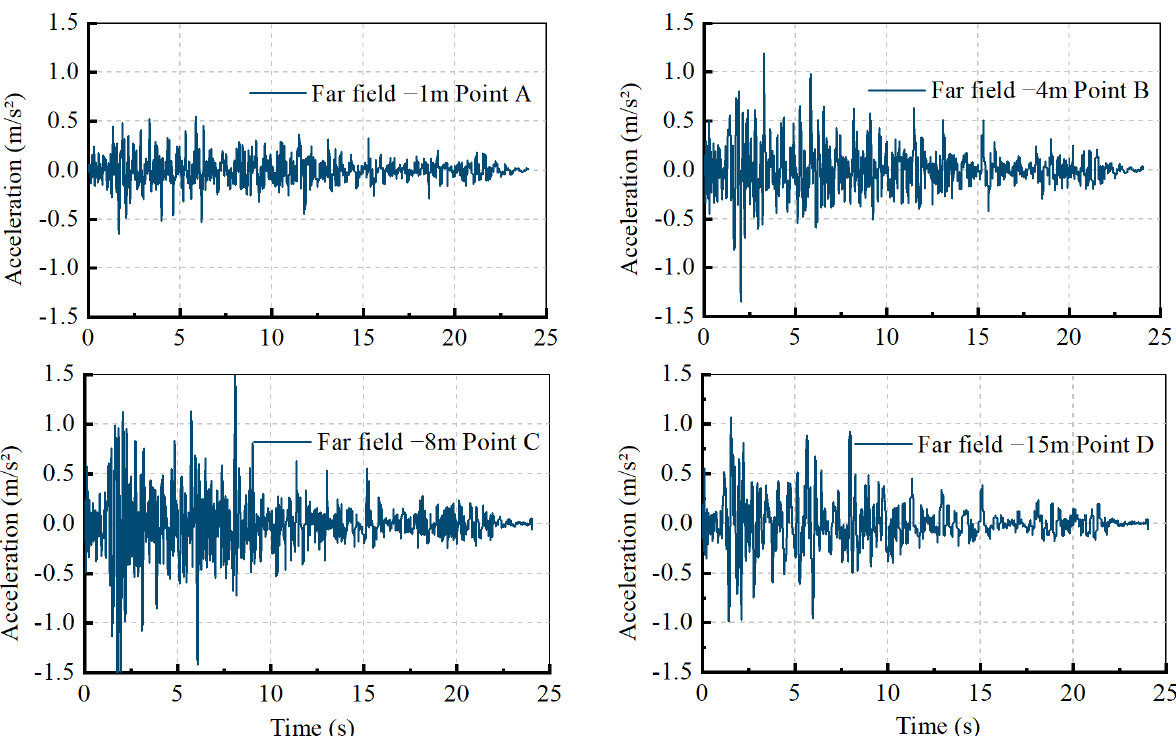
Figure 7. Acceleration time histories of soils at different depths in the far field in the 2 m burial depth model.